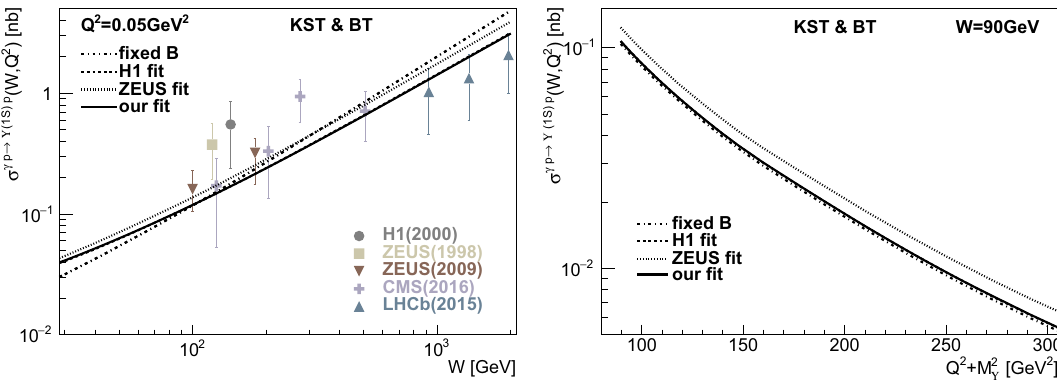
Fig. 8 The same as Fig. 7 but for the photo- and electroproduction of ϒ( 1 S ) state. The model predictions for σ γ ∗ p → ϒ p ( W , Q 2 ) are compared with the existing data from H1 [33], ZEUS [86,87], CMS [88] and LHCb [89] experiments